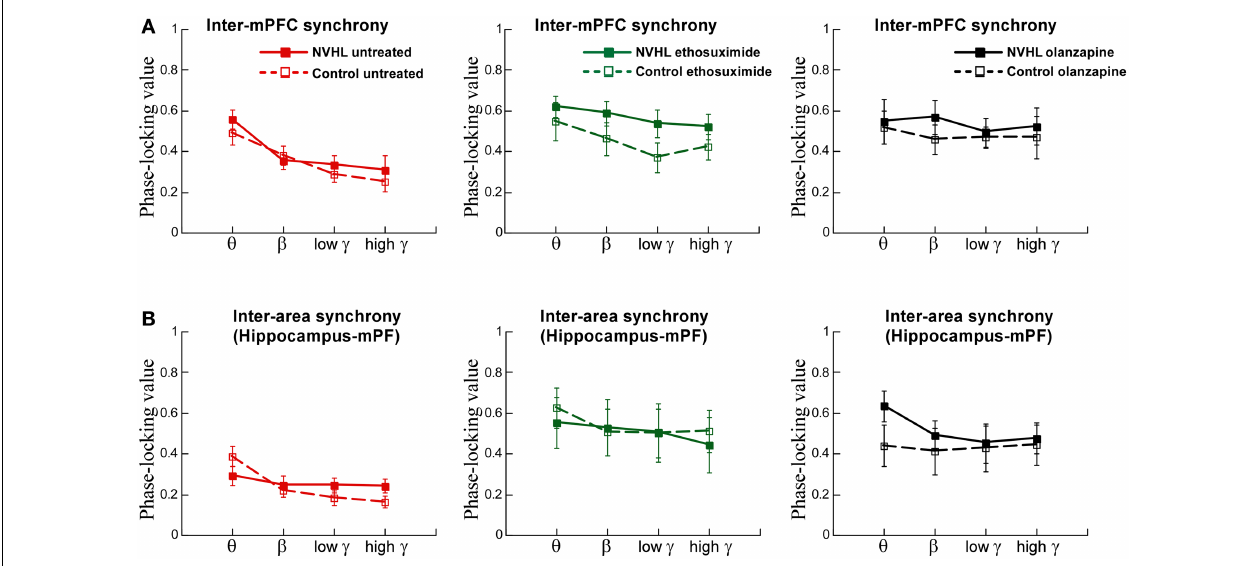
interaction: F 3,28 = 0.11, p = 0.95) groups. (B) Inter-area synchrony (between mPFC and hippocampus) was frequency-dependent but not different between the NVHL and control rats in the untreated group (left: two-way ANOVA group: F 1,32 = 0.43, p = 0.51; frequency: F 3,32 = 5.29, p = 0.005; interaction: F 3,32 = 2.05, p = 0.13).There were no group or frequency dependencies in the ethosuximide-treated rats because the drug increased synchrony at all frequencies to the level of the maximal (theta) inter-hippocampal synchrony (middle: two-way ANOVA group: F 1,32 = 0.11, p = 0.74; frequency: F 3,32 = 0.30, p = 0.83; interaction: F 3,32 = 0.07, p = 0.97).The olanzapine-treated NVHL rats had greater synchrony at all frequencies and there was no frequency dependence because the drug also increased synchrony at all frequencies (right: two-way ANOVA group: F 1,28 = 1.22, p = 0.28; frequency: F 3,28 = 0.26, p = 0.85; interaction: F 3,28 = 0.19, p = 0.90)